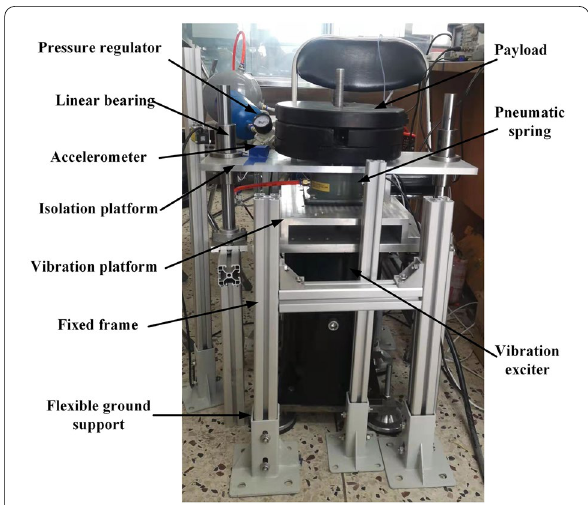
Figure 12 Pneumatic vibration isolation testing system